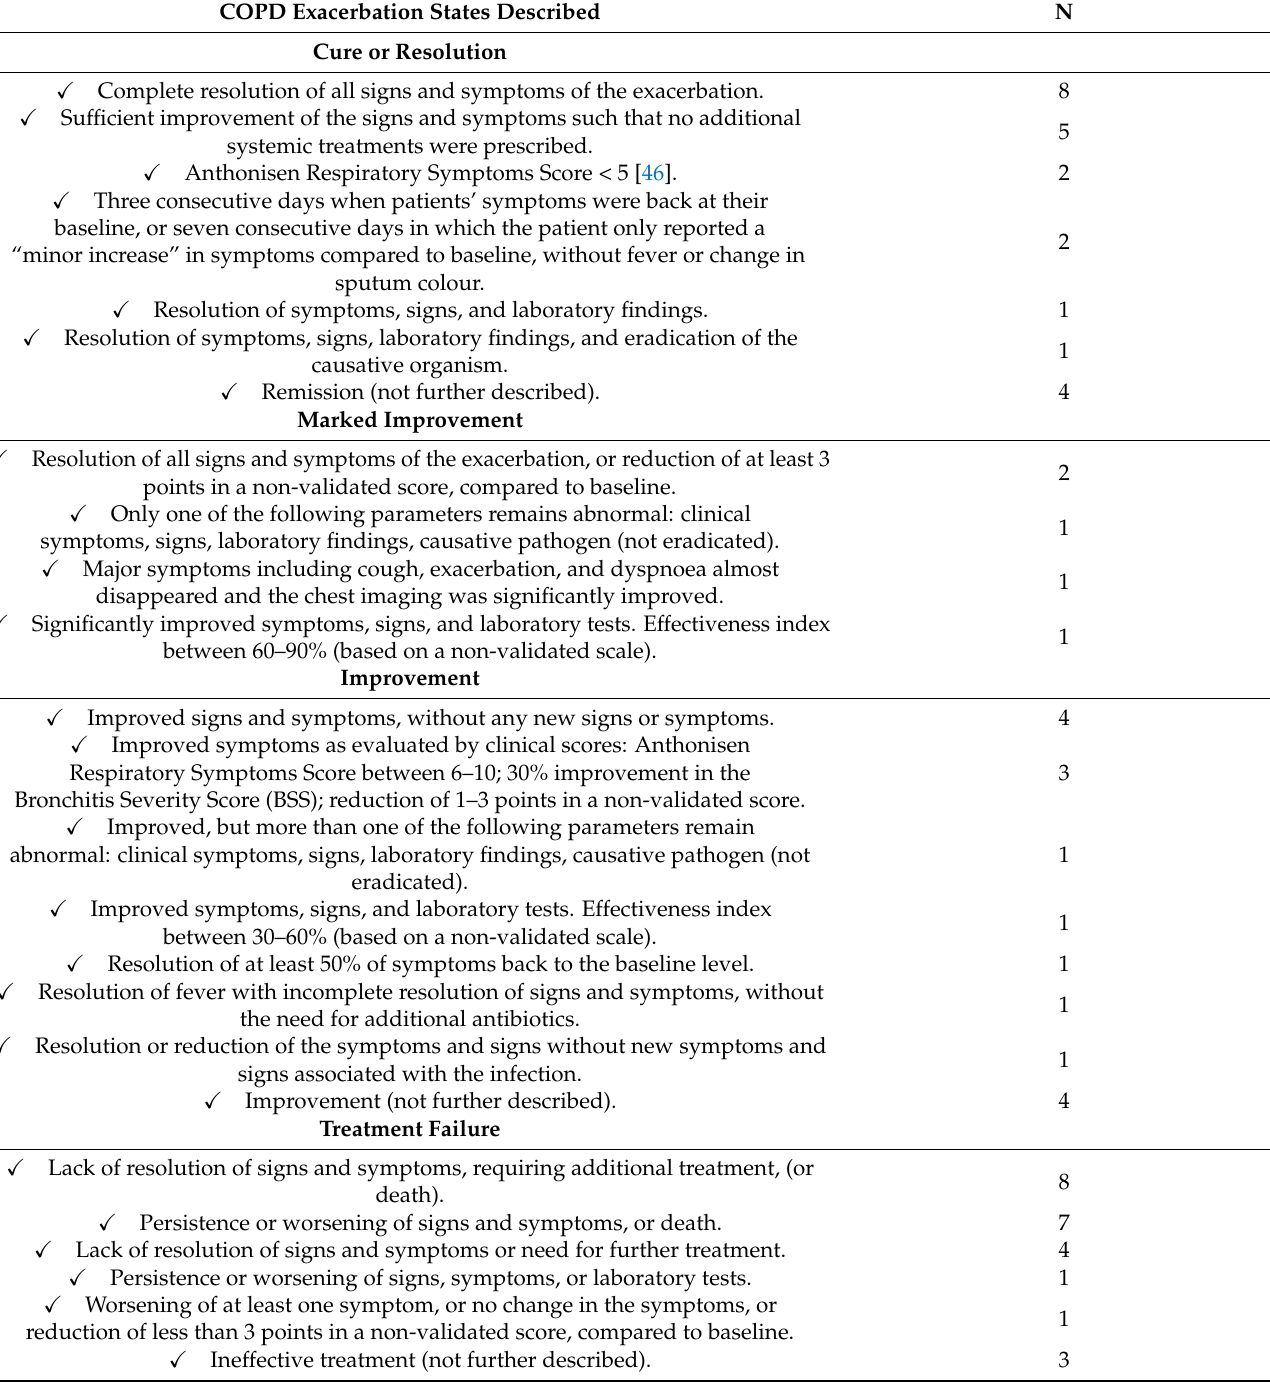
Table 5. Definitions of various COPD exacerbation states within descriptive instruments. COPD Exacerbation States Described N Cure or